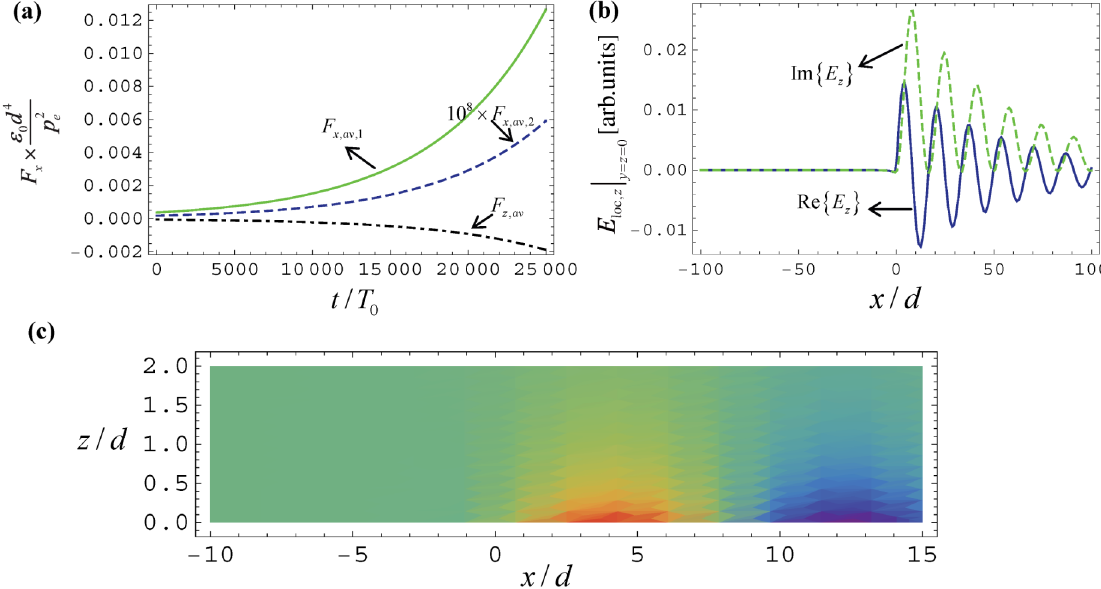
d=c ¼ 0 . 0135 ) above a thick sp is the time- z; av d ¼ 0 . 07 c . The time axis is normalized to T 0 ¼ λ 0 =c , sp . sp